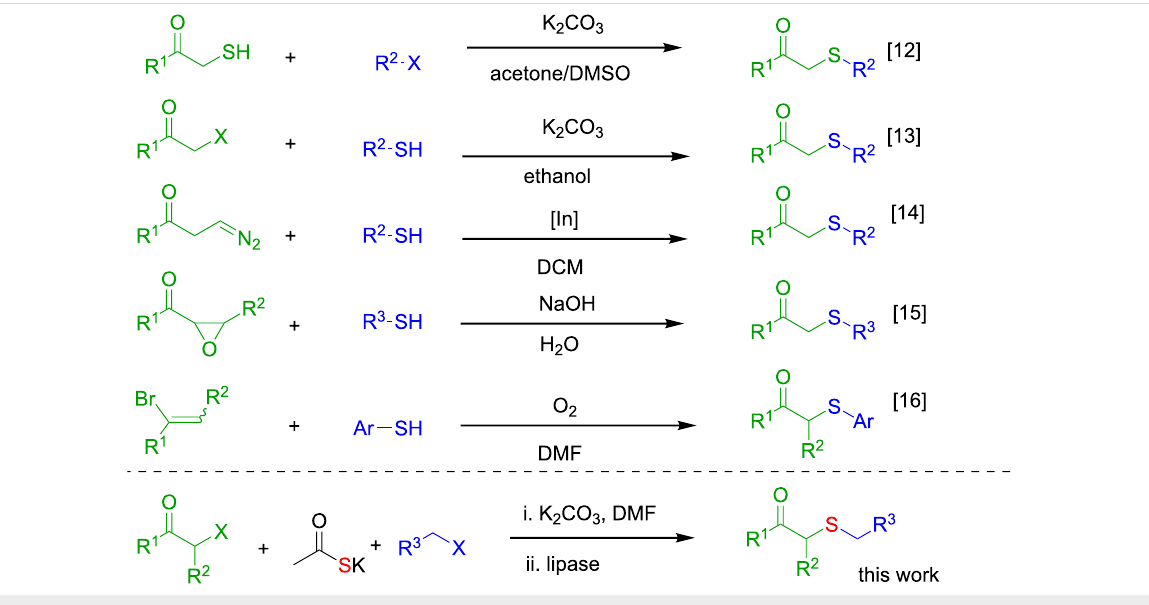
Scheme 1: Different strategies for the preparation of β